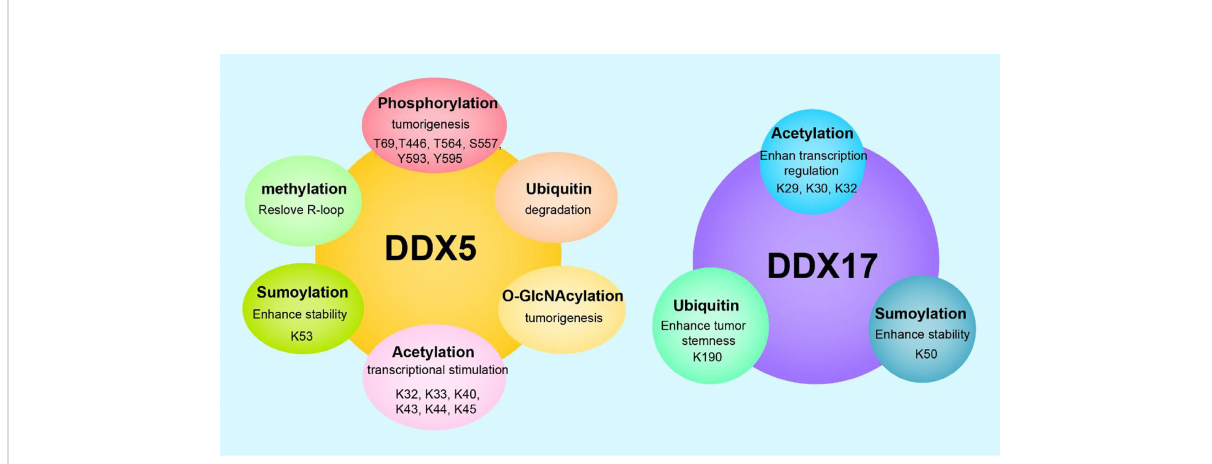
FIGURE 2 Posttranslational modi fi cations and functions of DDX5/DDX17. DDX5 can undergo phosphorylation, acetylation, methylation, ubiquitination, sumoylation, O-GlcNAcylation, etc. DDX17 can undergo acetylation, ubiquitination, sumoylaton, etc. Different posttranslational modi fi cations endow DDX5/DDX17 with diverse biological functions, and the same modi fi cation at different sites leads to different functional